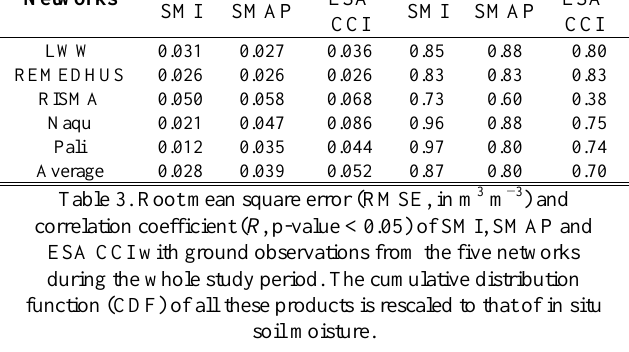
Figure 5. Similar to Figure 3 but with bias-corrected SMI (i.e., SMI-CDF) by using the CDF matching technique. RMSE (m 3 m −3 ) Networks